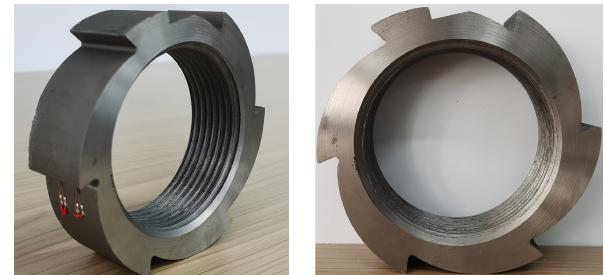
Figure 10. Experimental ratchet.